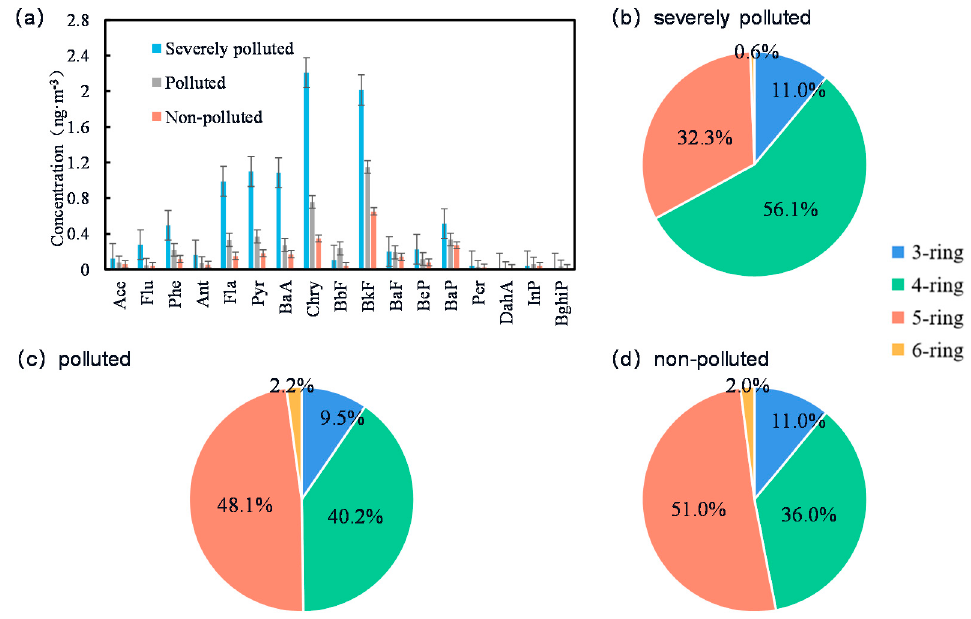
Figure 4. ( a ) Monomer average concentration and ( b – d ) distribution of different ring number of 17 PAHs in PM 2.5 in different polluted days.